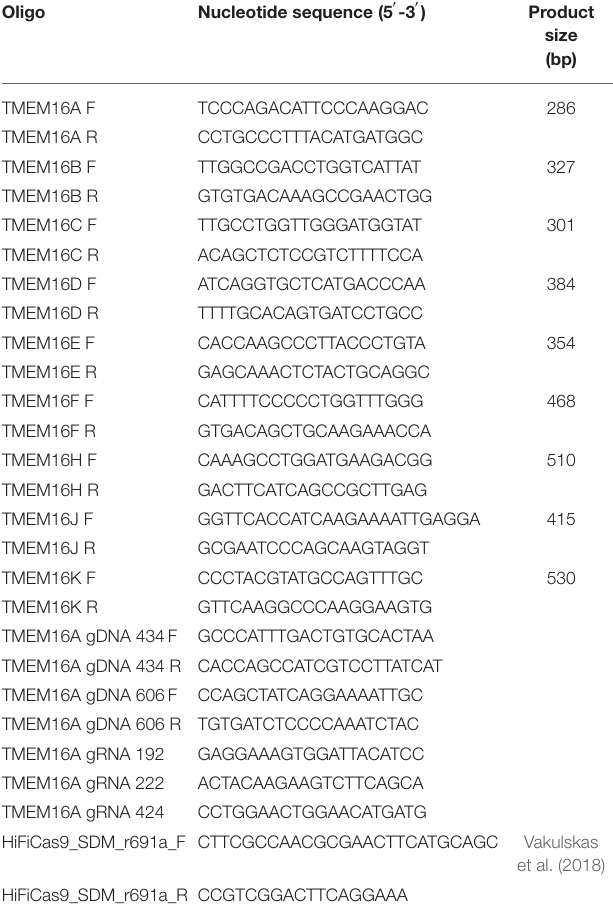
TABLE 2 | Oligonucleotide sequences from the work in this paper. Oligo Nucleotide sequence (5 ′ -3 ′